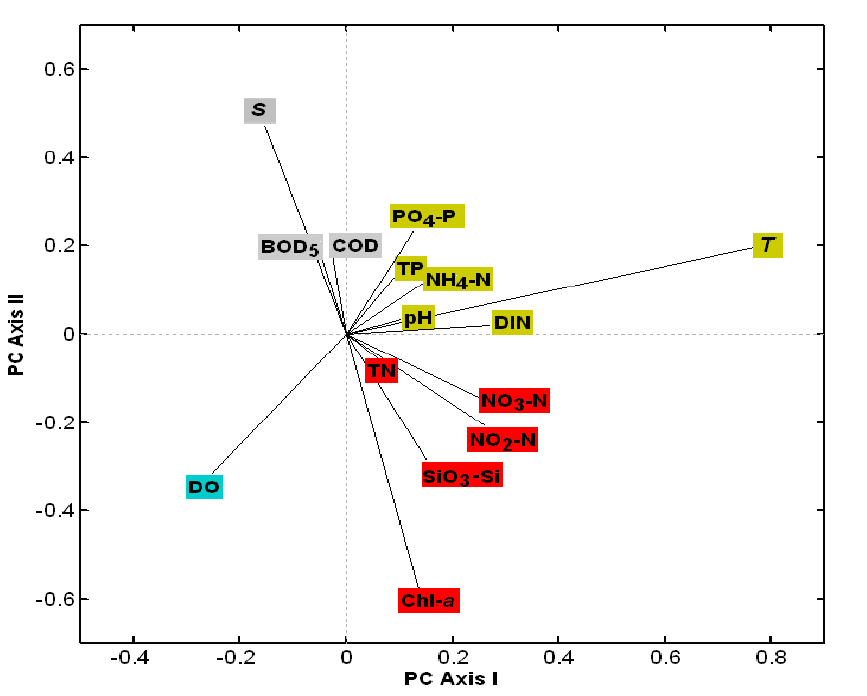
Figure 5. Principal component analysis (PCA) (Axis I and II) made on the loadings of environment variables ( a ) and the scores of the 12 stations in four seasons ( b ) in